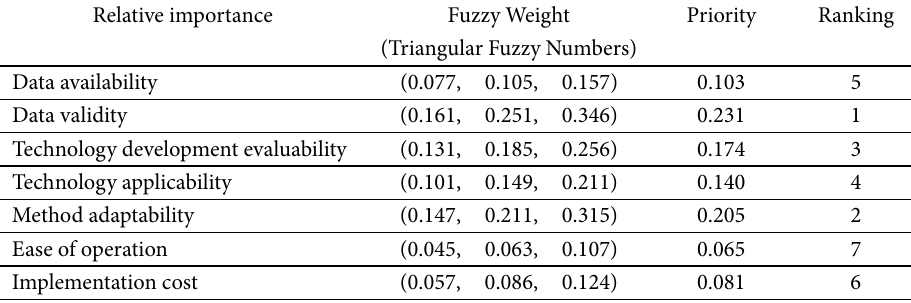
Table 2. Priorities of evaluation criteria with respect to the goal Relative